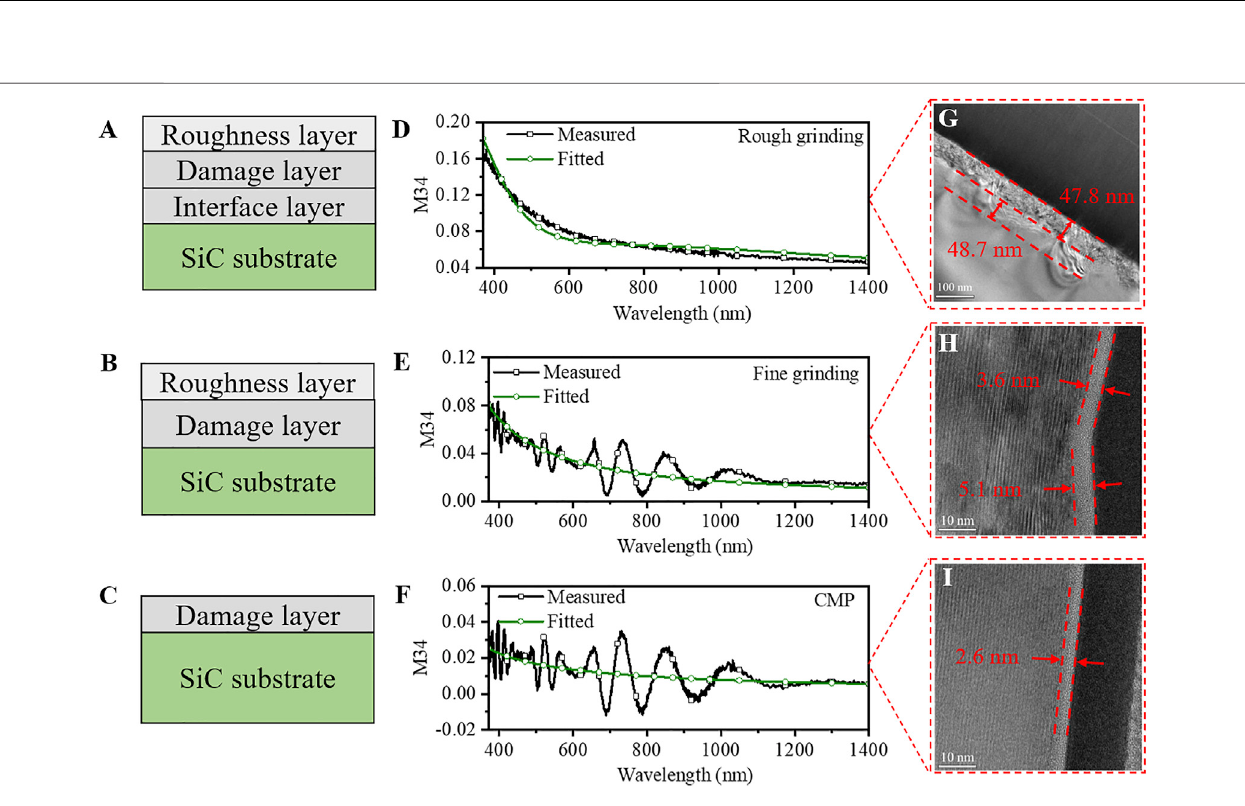
Frontiers in Physics |